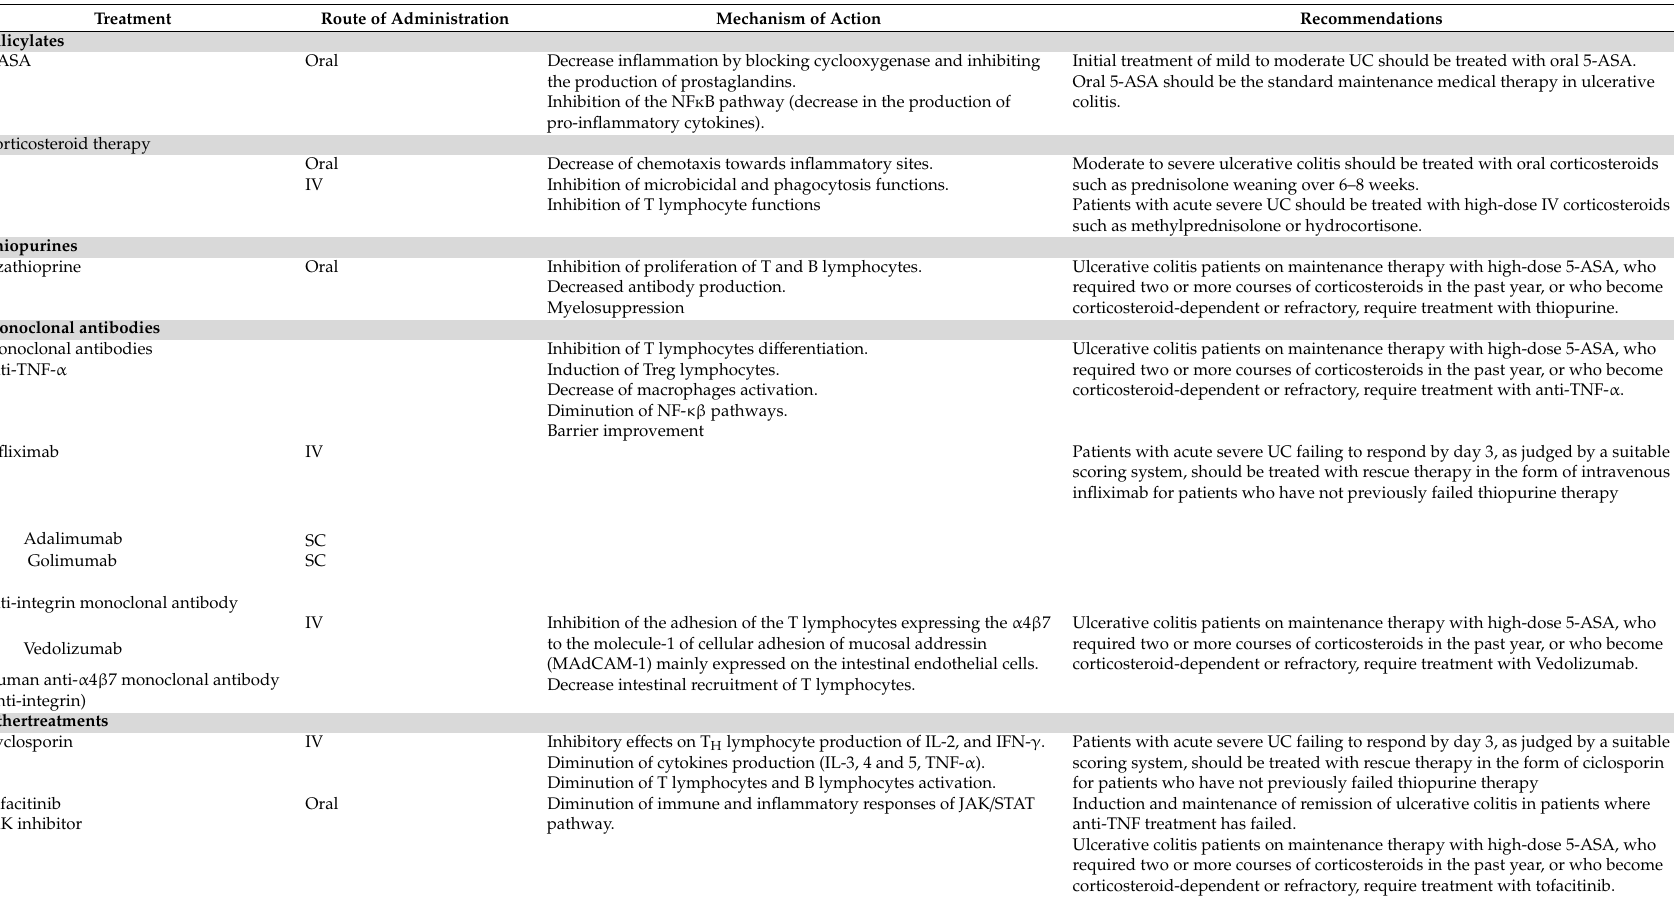
Table 2. Medical treatments used in ulcerative colitis according to 2019 consensus British Society of Gastroenterology guidelines